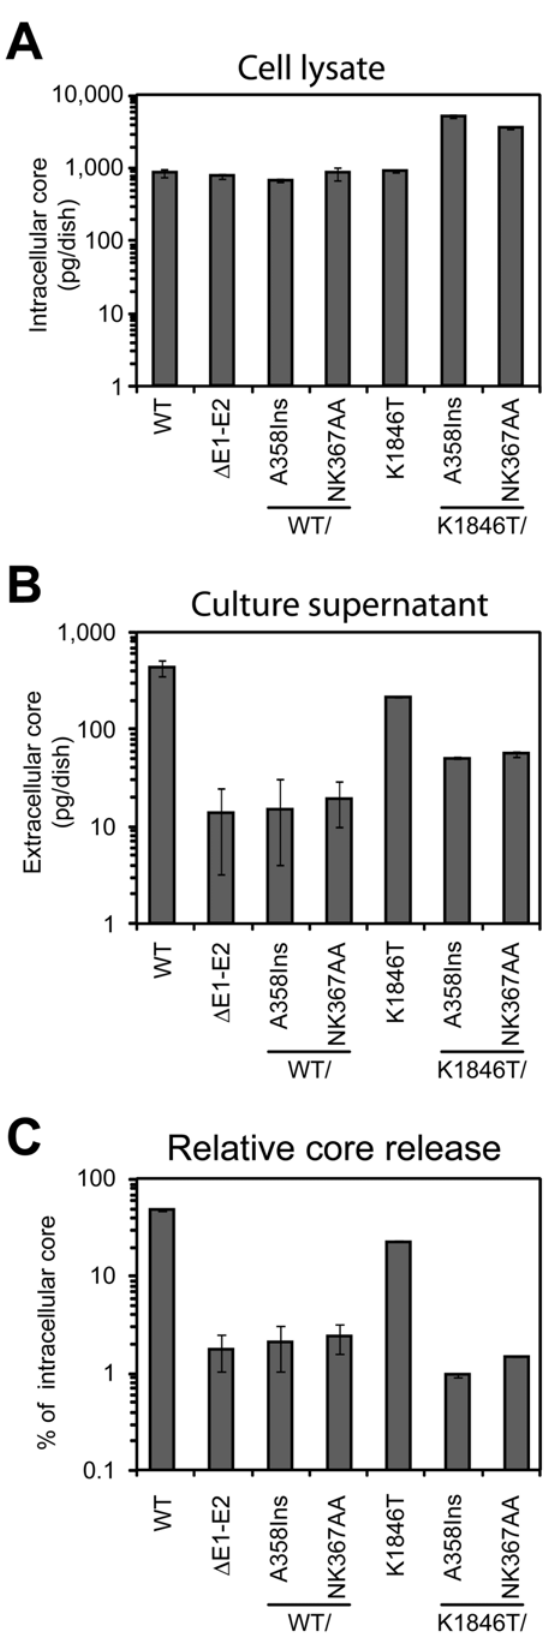
Figure 3. Release of HCV core into the supernatant of transfected cells depends on the expression of functional glycoproteins. Ten m g of in vitro transcribed RNA of the constructs specified below each bar were transfected into Huh-7 cells and 24 h later culture medium was harvested and filtered, whereas cells were lysed with 1% Triton X-100 in PBS. The total amount of HCV core in the cell lysate (A) and culture supernatant (B) was determined by ELISA. (C) Relative core release expressed as the fraction (in %) of total intracellular core protein that is released into the culture fluid. Mean values of two independent electroporations including the standard error of the means are